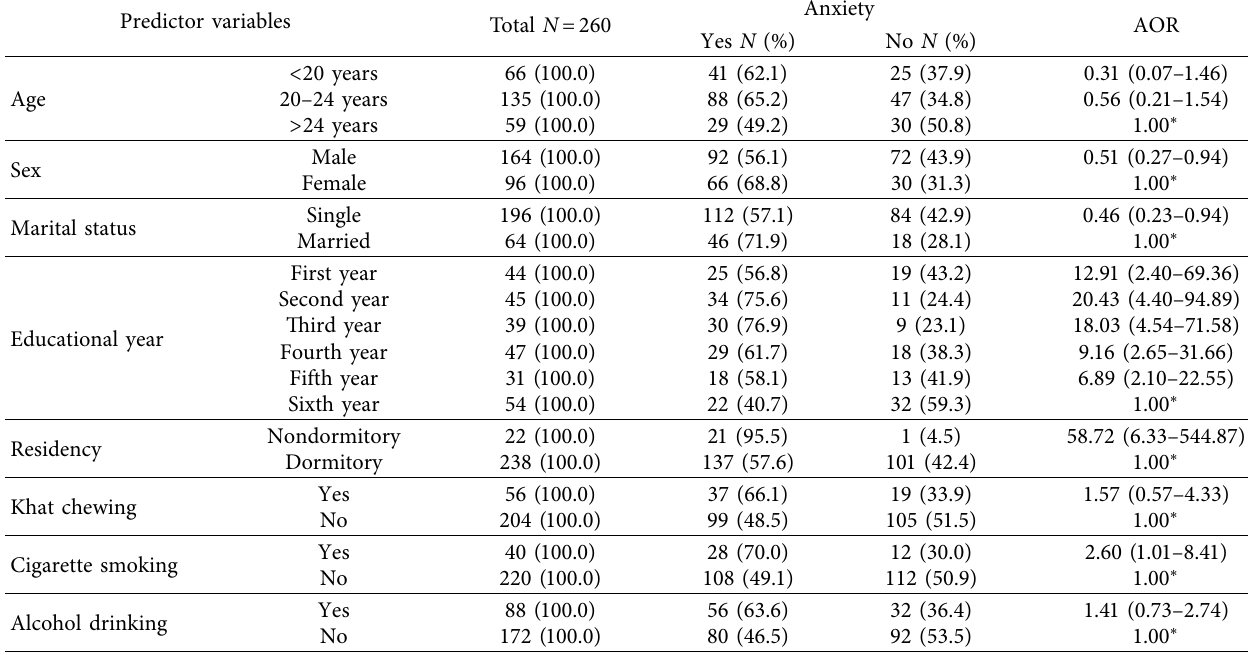
Table 9: Multiple logistic regressions of anxiety and predictor variables, N � 260, AU, January 2019.